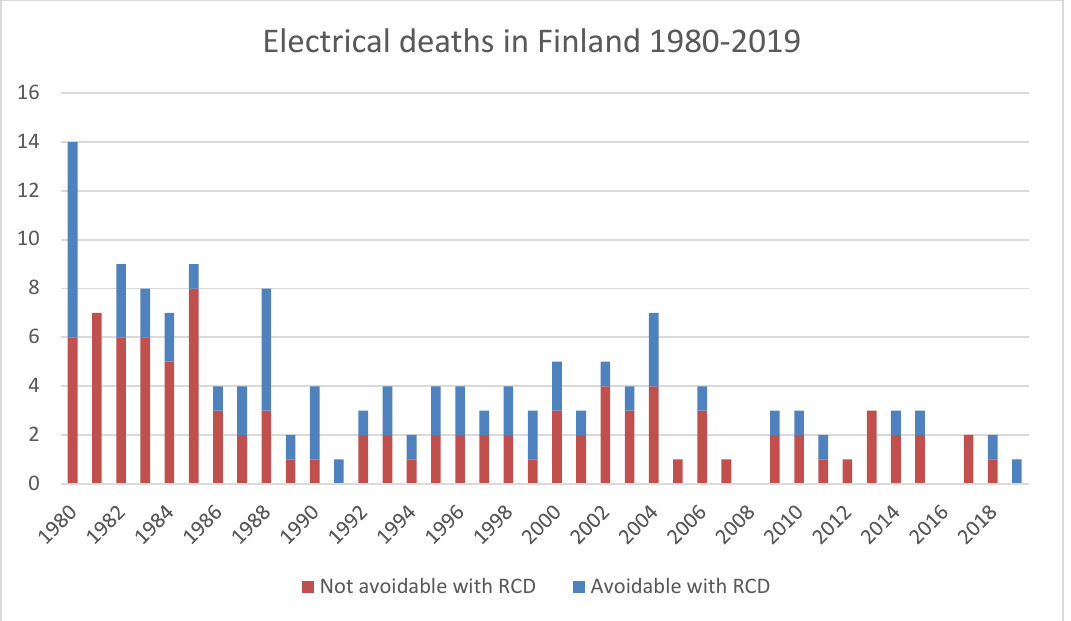
Figure 2. Total electrical deaths in Finland 1980–2019